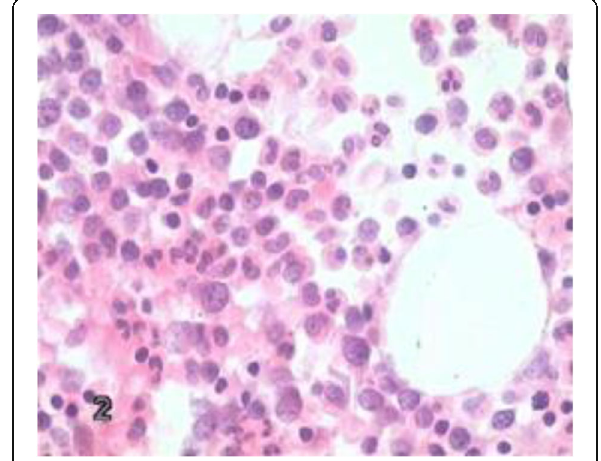
Fig. 2 Bone marrow biopsy showed no evidence of leukemic infiltration (original magnification, ×